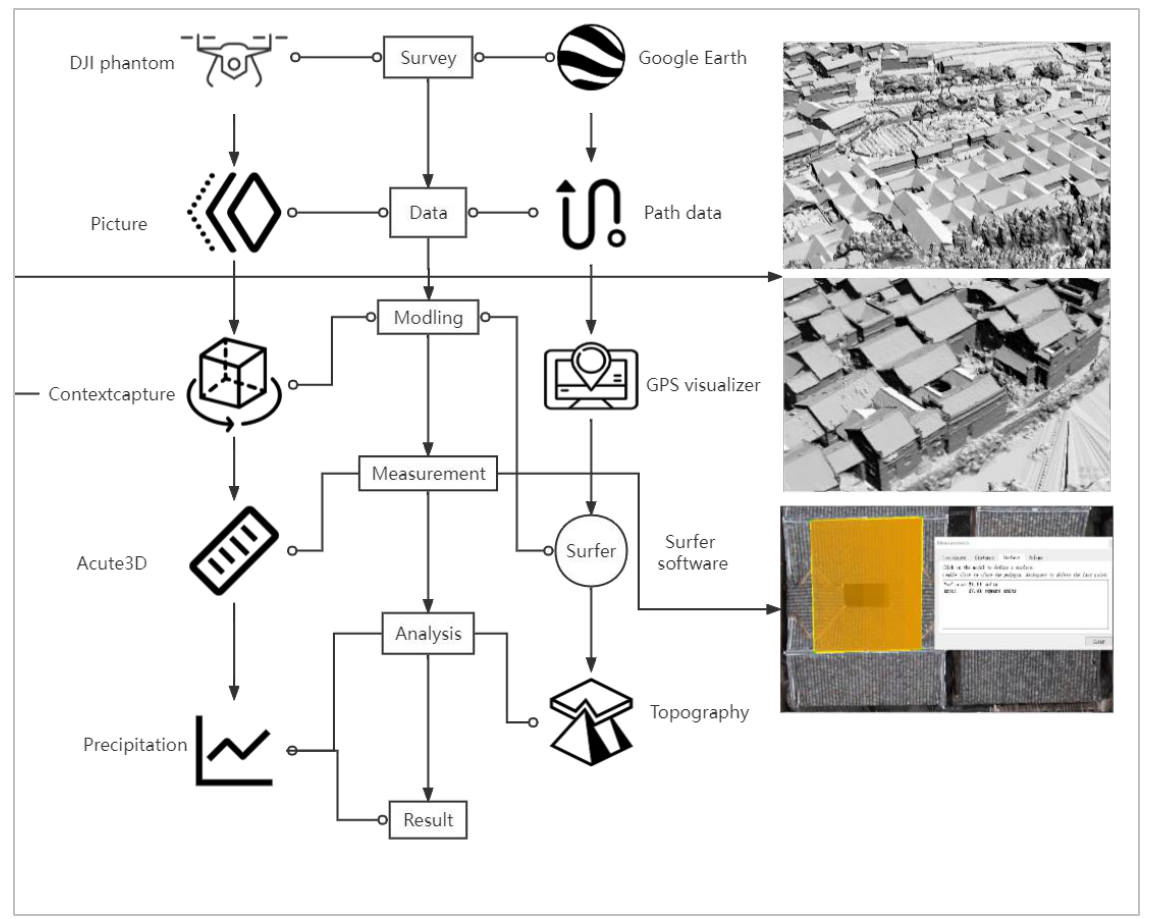
Figure 2. Conceptual framework of the research process. Table 2. The table of the 3D model water catchment area